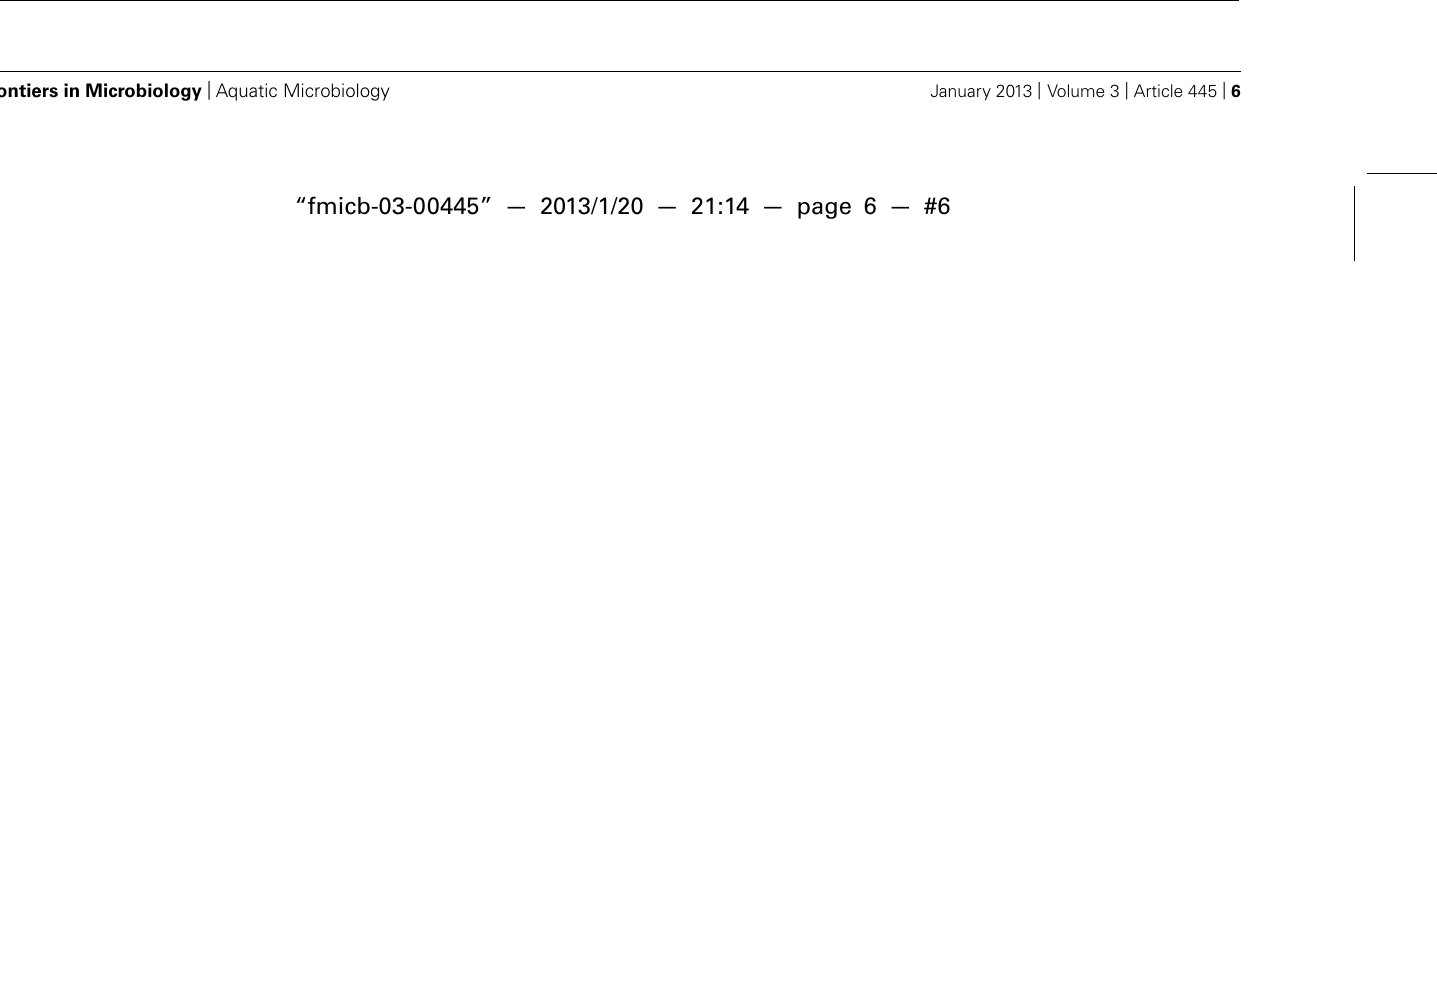
FIGURE 4 | Distribution of betaproteobacterial amo A clones (A) and archaeal amo A clones (B) related to fertilization rates. Groups are based on phylogenetic clusters designated in Figures 3 and 5 .The number of sequences used to generate data points for each fertilization rate are shown in